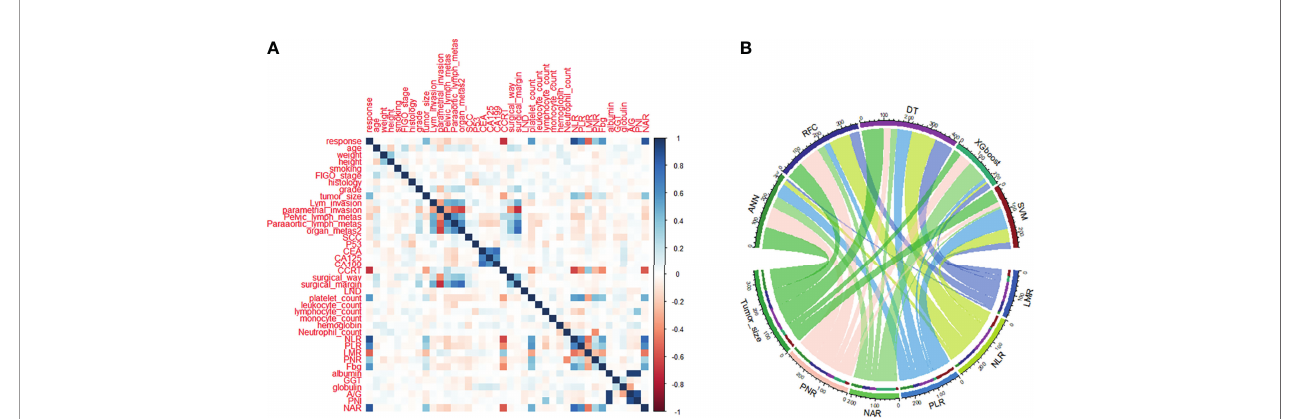
FIGURE 2 | Variable screening and weight allocation. (A) Correlation matrix analysis of candidate features. (B) Weight distribution of the candidate variables of each ML-based model. ADC, denocarcinoma; A/G, albumin-to-globulin ratio; ANN, arti fi cial neural network; CA125, cancer antigen 125; CA199, cancer antigen 199; CCRT, concurrent chemoradiotherapy; CEA, carcinoembryonic antigen; CIC, clinical impact curve; DCA, decision curve analysis; DT, decision tree; FIGO, International Federation of Gynecology and Obstetrics; GGT, serum g -glutamyltransferase; LMR, lymphocyte-to-monocyte ratio; LND, lymph node dissection; NAR, neutrophil-to-albumin ratio; NLR, neutrophil-to-lymphocyte ratio; PLR, platelet-to-lymphocyte ratio; PNI, prognostic nutrition index; PNR, platelet-to-neutrophil ratio; RFC, random forest classi fi er; ROC, receiver operating characteristic curve; SCC, squamous cell carcinoma; SVM, support vector machine; XGboost, eXtreme gradient